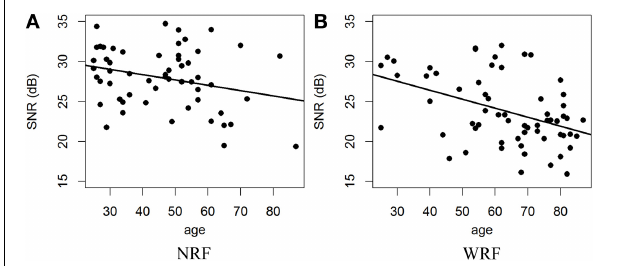
FIGURE 6 | Scatter plot linking the average SNR to the subjects’ age. The lines show the best linear models associated with these data. The plot (A) is for the population with No Risk Factor (NRF) and the plot (B) for the population With Risk Factor